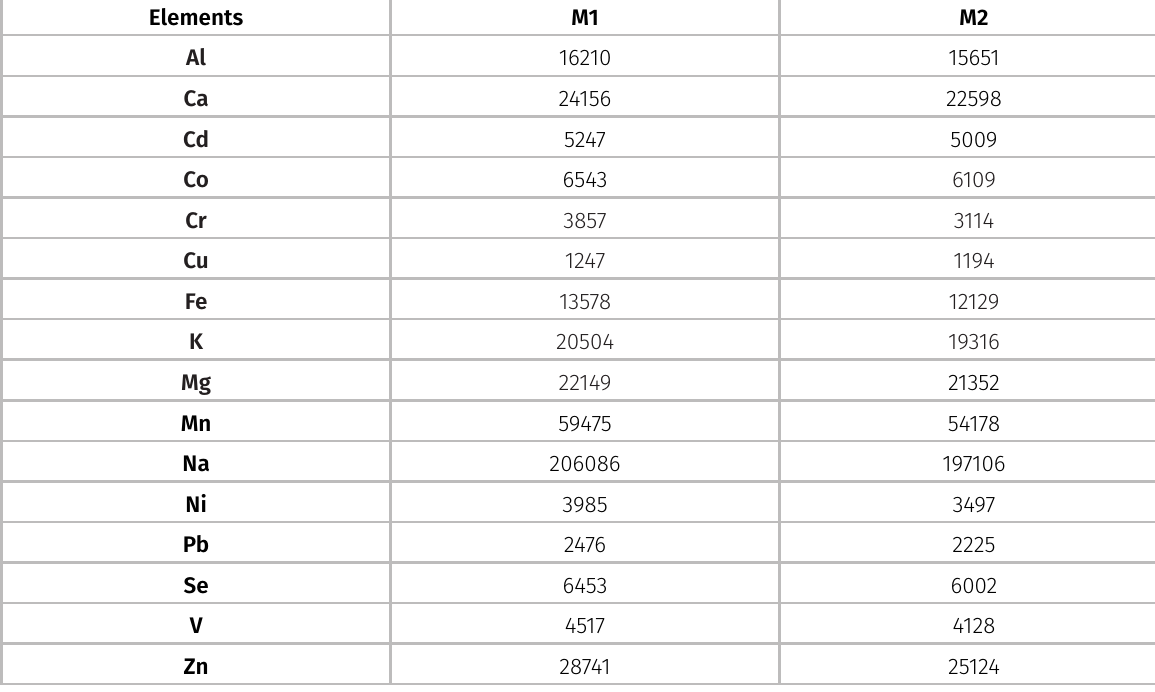
Table III. The slopes of the analytical curves for Al, Ca, Cd, Co, Cr, Cu, Fe, K, Mg, Mn, Na, Ni, Pb, Se, V and Zn by ICP OES in M1 (2 mol L -1 HNO ) and M2 (honeys after microwave radiation 3